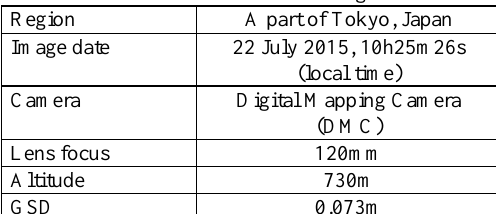
Table 2. Details of aerial imageries